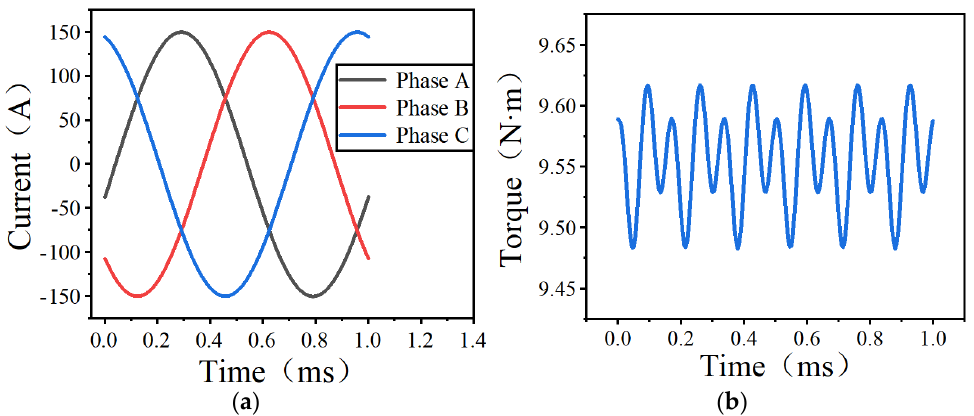
Figure 11. The current and torque waveforms of the HSPMM under full-load conditions. ( a ) Current waveform; ( b ) torque waveform. Table 6. Structure and electromagnetic parameters of the 30 kW, 30,000 r/min HSPMM.